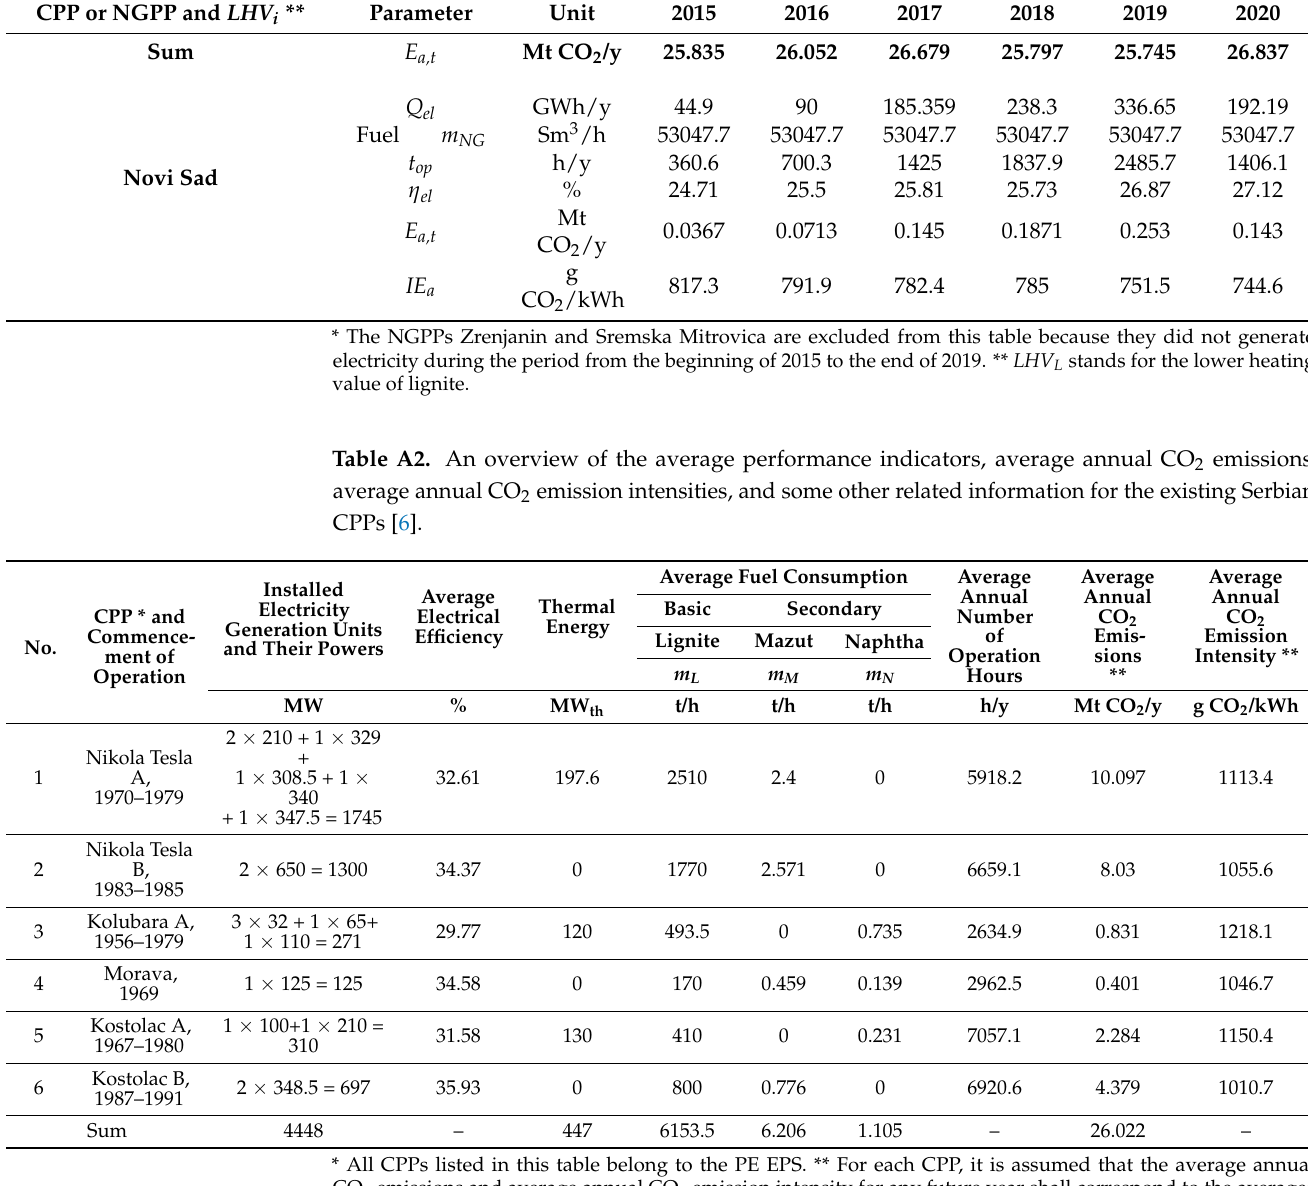
Table A3, regardless of the commencement date of operation. When definition (A12) takes into account heat generation, it becomes apparent that IE a can have a significantly lower value when compared to the corresponding value from Table A2 or Table A3. This applies to each CPP or NGPP that generates both electricity and heat. This could certainly be the topic of a future